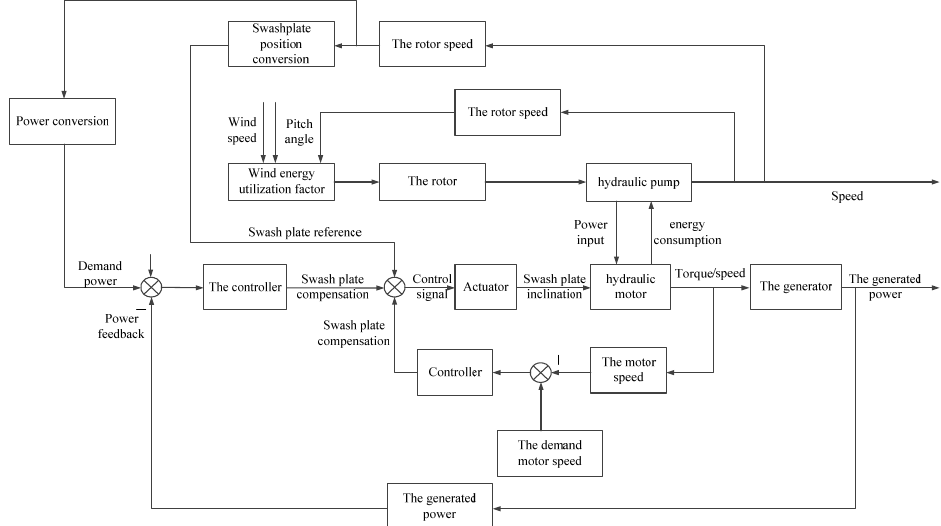
Figure 3. HWT MPPT control block diagram.